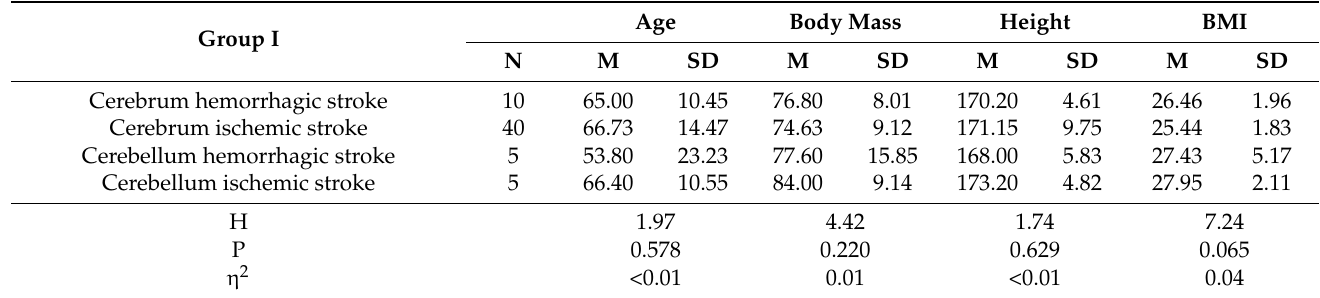
Table 1. Biometric data of the Group I—first post-stroke study